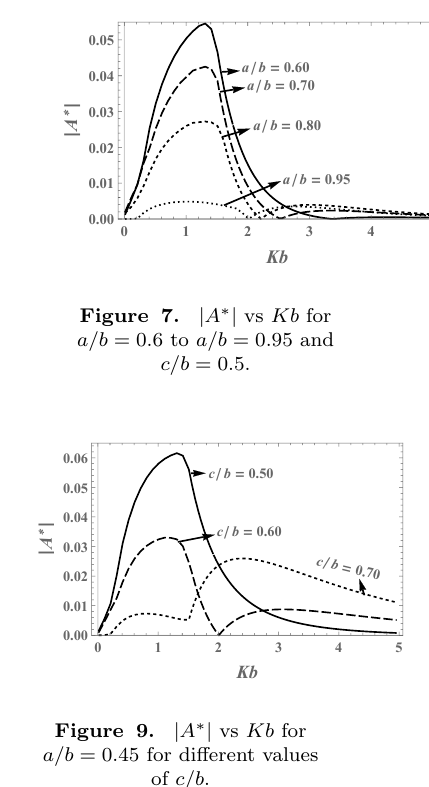
Figure 9. | A ∗ | vs Kb for a/b = 0 . 45 for different values of c/b .